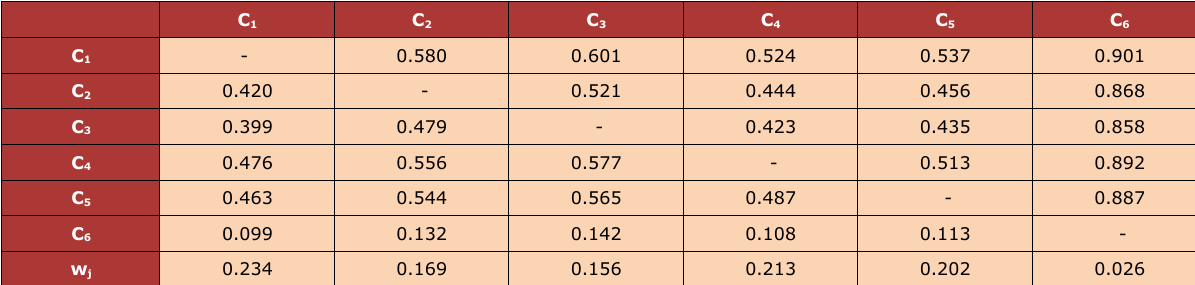
Table 9. Pair-wise comparison of criteria with respect to each other